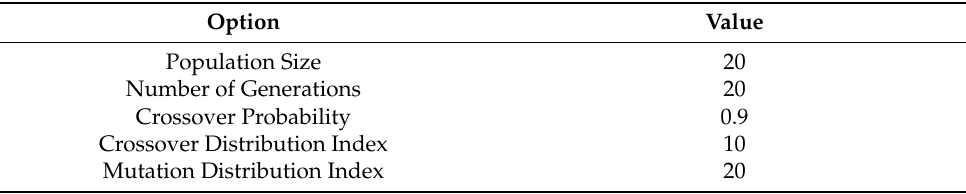
Table 9. The general information on